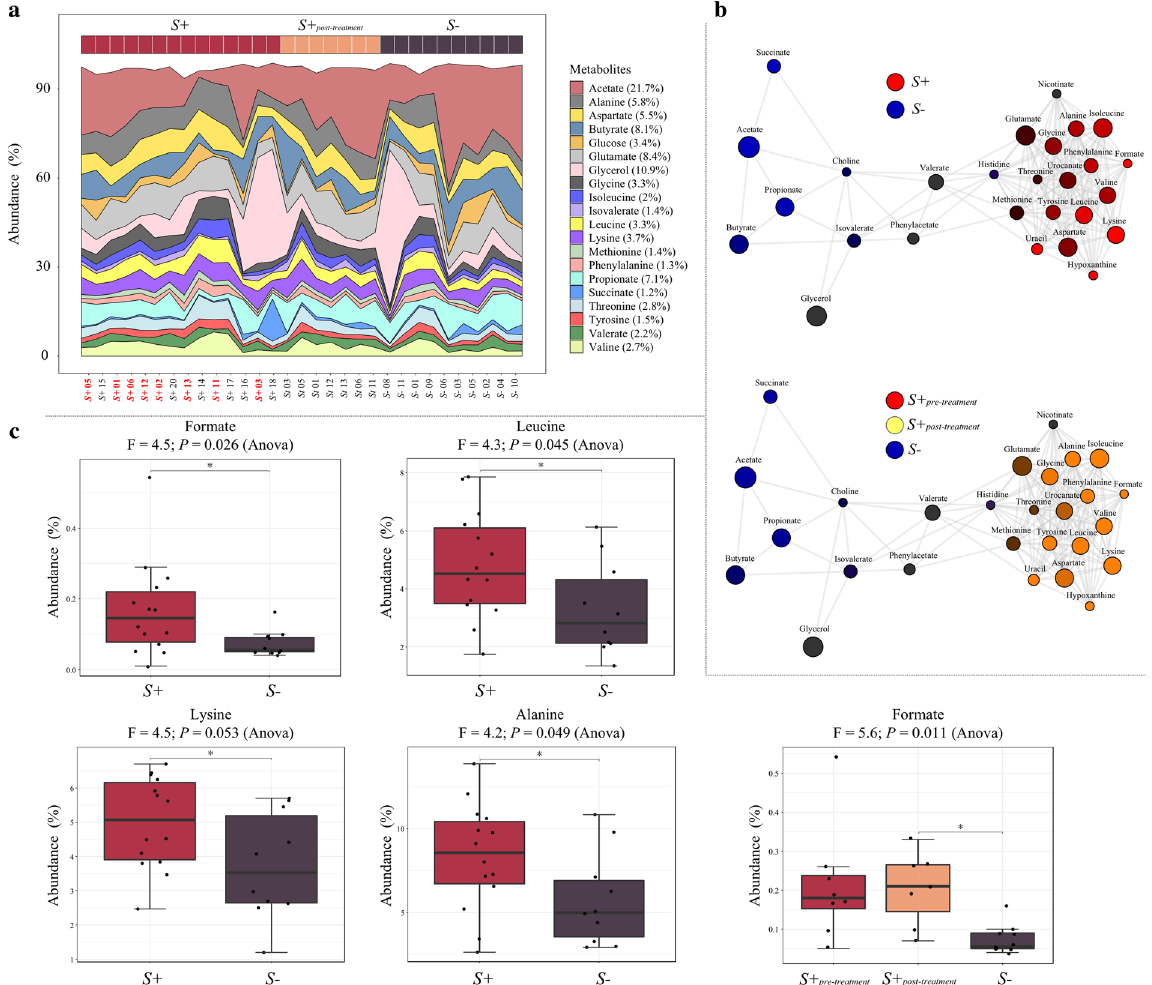
Figure 5. Decreased levels of selected short chain fatty acids (SCFAs) and increased levels of amino acids are associated with Strongyloides stercoralis infection. ( a ) Area plot indicating the abundance (expressed as percentage) of metabolites detected by nuclear magnetic resonance analysis (NMR) in faecal samples from S . stercoralis -infected and uninfected subjects ( S + in red, and S − in purple), as well as from the subset of S + subjects that had received anthelmintic treatment, both prior to ( S + pre-treatment , red sample label) and 6 months post-ivermectin administration ( S + post-treatment , in orange). ( b ) Network analysis displaying associations between individual or clusters of metabolites and sample groups (i.e. S + in red, S − in blue [top network], S + pre-treatment in red, S + post- treatment in yellow and S − in blue [bottom network]). For metabolites associated with multiple sample groups, the respective circle colours are mixed according to the strength of the association. ( c ) Differentially abundant metabolites detected in faecal samples from S + and S − , as well as S + pre-treatment , S + post-treatment , and S − subjects, determined using ANOVA. The bold and black horizontal lines in the boxplots refer to the mean of percentage abundance of metabolite associated with the corresponding group, with top and bottom whiskers representing the standard deviation. Significant differences between study groups are marked by an asterisk ( *